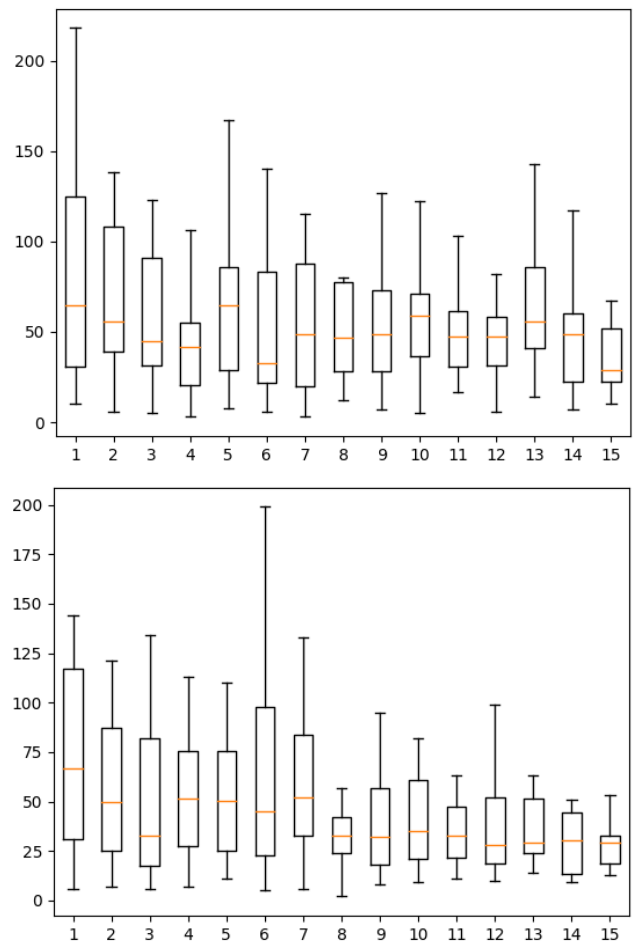
Figure 8. Boxplots of the durations for participant to answer by index until the 15th answer of participants for variant 1 ( top ) and 2 ( bottom ) of the